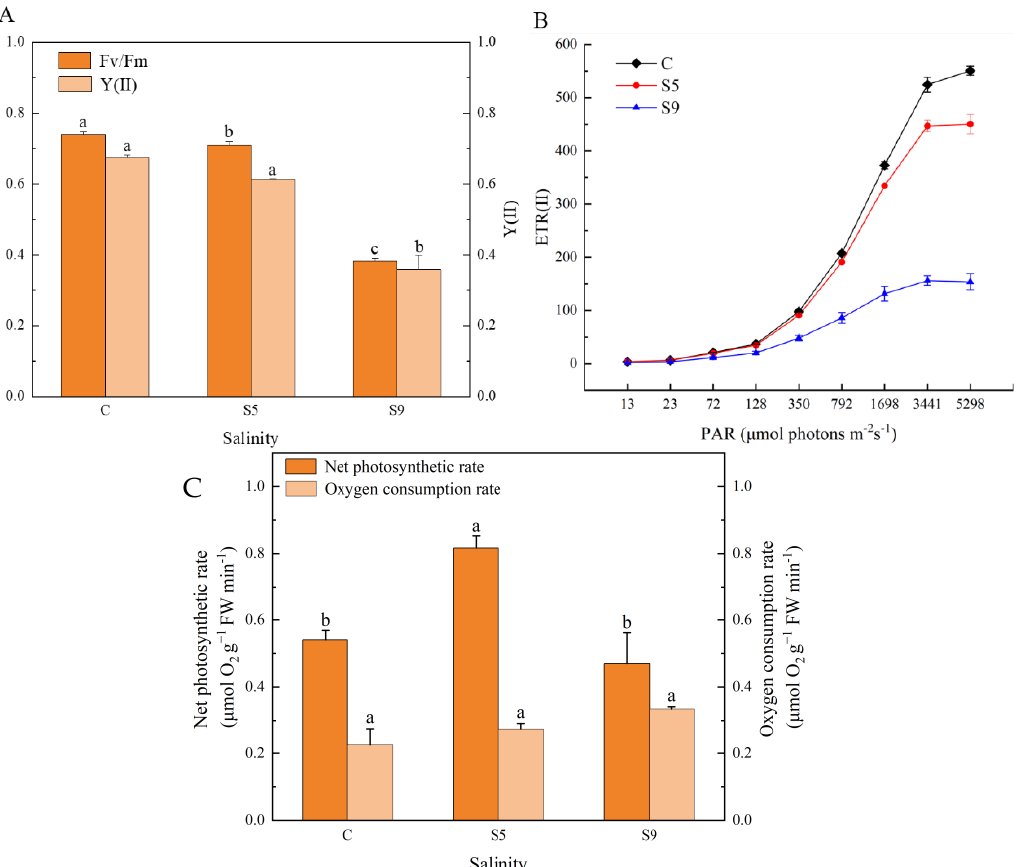
Figure 7. Photosynthetic physiological parameters ( A , B ) and rates of photosynthetic oxygen release and respiratory oxygen consumption ( C ) under salt stress. Note(s): In (A) and (C), different super- script letters (a, b, c) within the same physiological parameter show significant difference ( p < 0.05). (C: salinity 30 psu; S5: salinity 50 psu; S9: salinity 90 psu.)